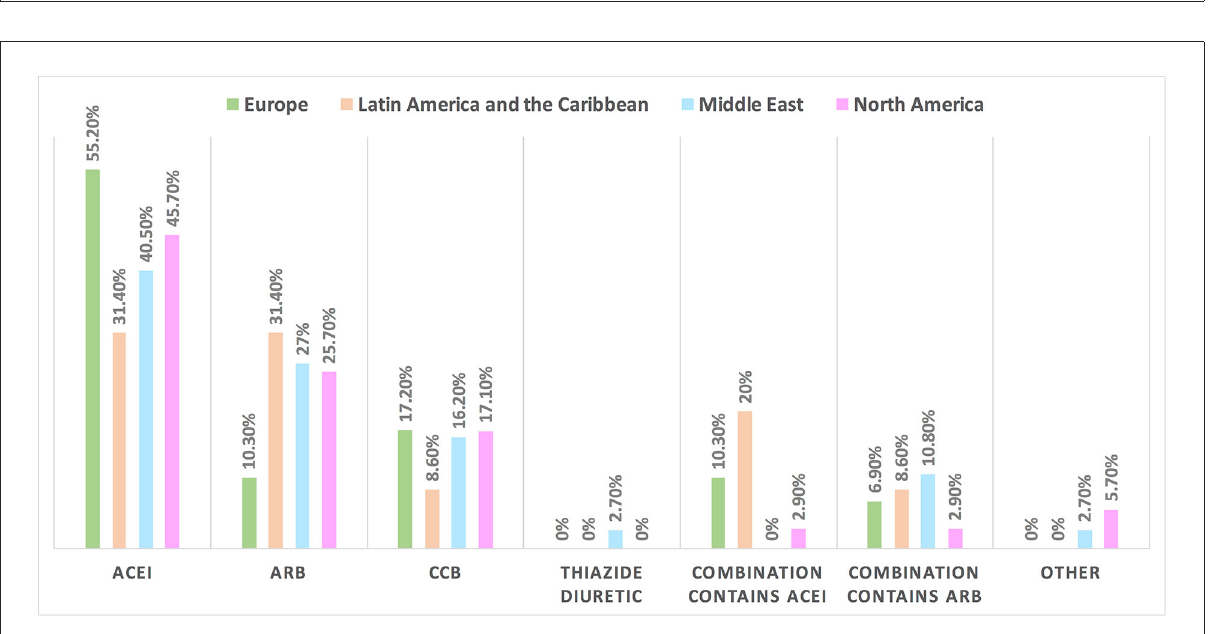
(Table 3). Experts in North America, Latin America and the Caribbean did not prefer the use of ARB over ACEI during the COVID-19 pandemic, unlike the Middle East and Europe